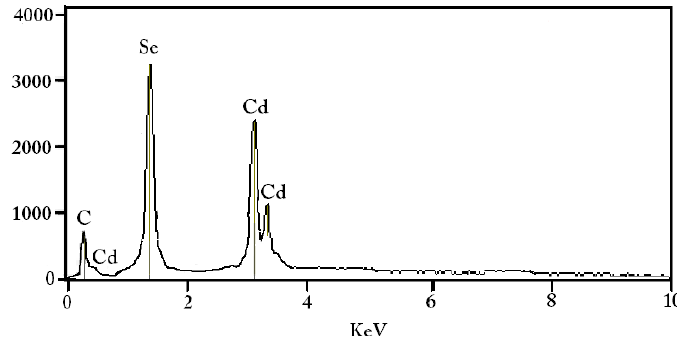
Figure 3. Energy dispersive X ‐ ray (EDX) compositional analysis of CdSe nanoparticles.